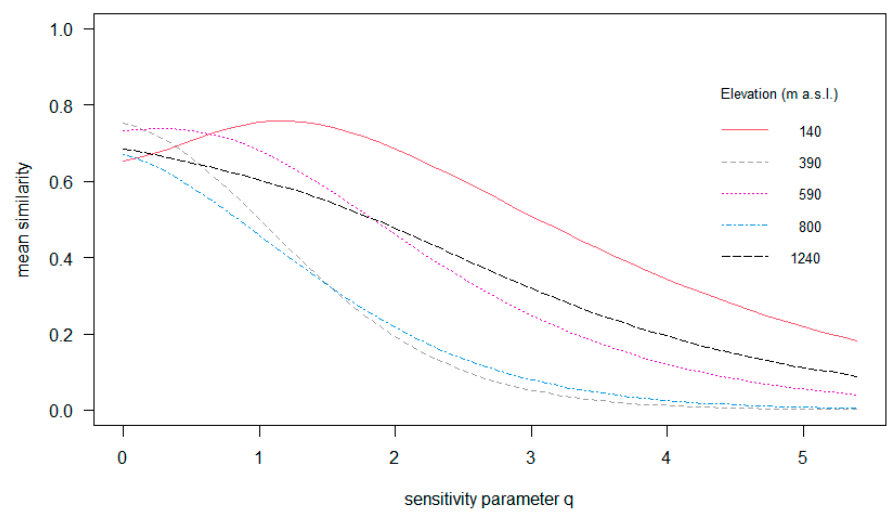
Figure 6. Multiple-assemblage similarity profile of epiphyte assemblages growing along the elevational gradient in Gualaca district. The graph illustrates the compositional differences in the epiphyte assemblages from different elevations using similarity indices that differ in their sensitivity to relative species abundance. The x- axis shows the orders of q (sensitivity parameter) and the y -axis shows the values of mean similarity, from 0 = assemblages being completely distinct to 1.0 = assemblages being identical.